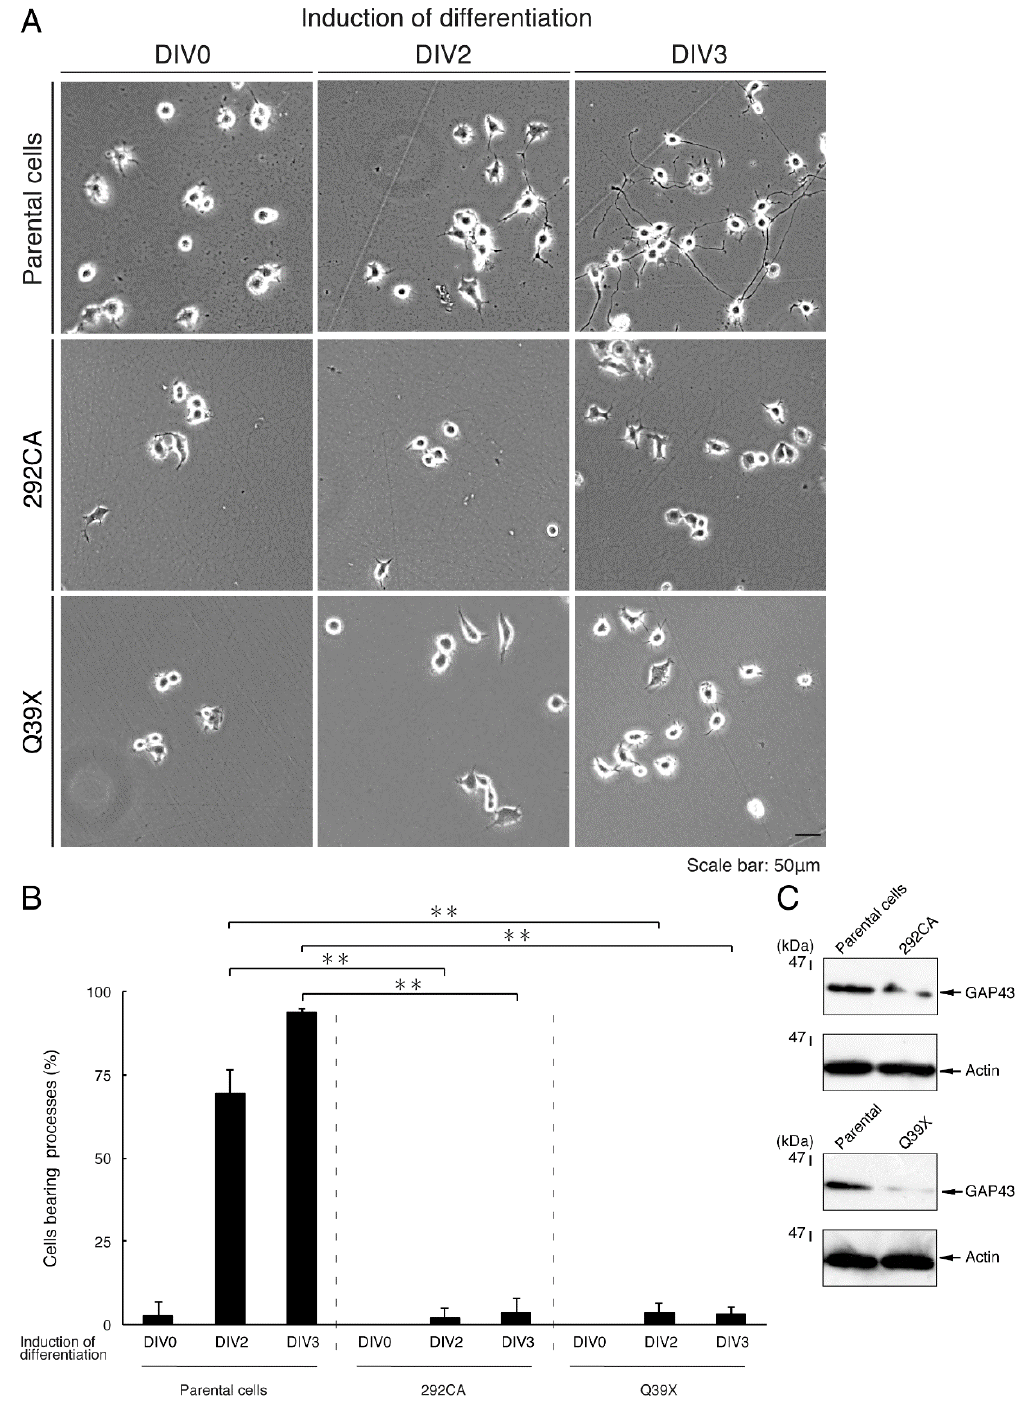
Figure 10. Cells harboring each of the AIMP1 mutant constructs fail to exhibit di ff erentiated phenotypes. ( A , B ) We allowed N1E-115 cells stably harboring the 292CA or Q39X mutant constructs of AIMP1 or parental cells to di ff erentiate for 0, 2, or 3 days (DIV0, DIV2, or DIV3). The scale bar indicates 50 µ m. Percentages of di ff erentiated cells bearing neurite-like processes that were at least one cell body in length are statistically shown (**, p < 0.01; n = 3 fields [total 240 cells]). ( C ) On day 3 following the induction of di ff erentiation, cells were lysed and immunoblotted with an anti-GAP43 or actin antibody.